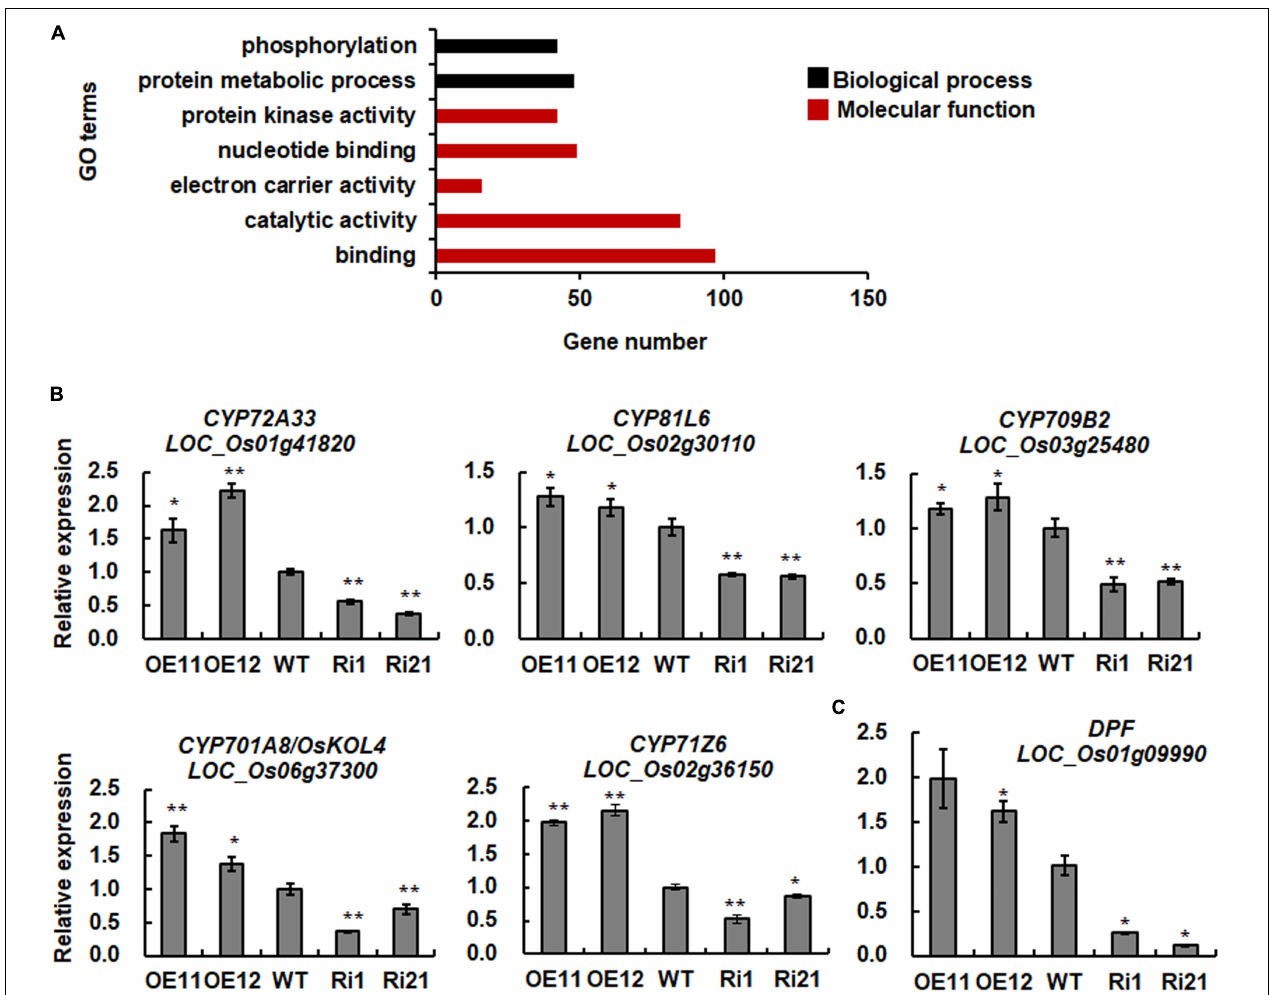
FIGURE 5 | Enriched GO terms of genes co-expressed with ONAC066 and expression of the selected cytochrome P450 genes and DPF in ONAC066 -OE and ONAC066 -Ri plants. (A) Enriched GO terms of genes co-expressed with ONAC066. (B) Expression of selected cytochrome P450 genes. (C) Expression of DPF . Data represented in panels (B,C) are the means ± SD from three independent experiments and **/* indicated significant difference at p < 0.01 and p < 0.05 levels, respectively, by Student’s t -test, in comparison to